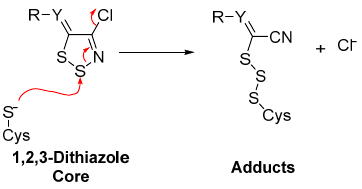
Figure 41. The 1,2,3-dithiazole as a latent cystine reactive